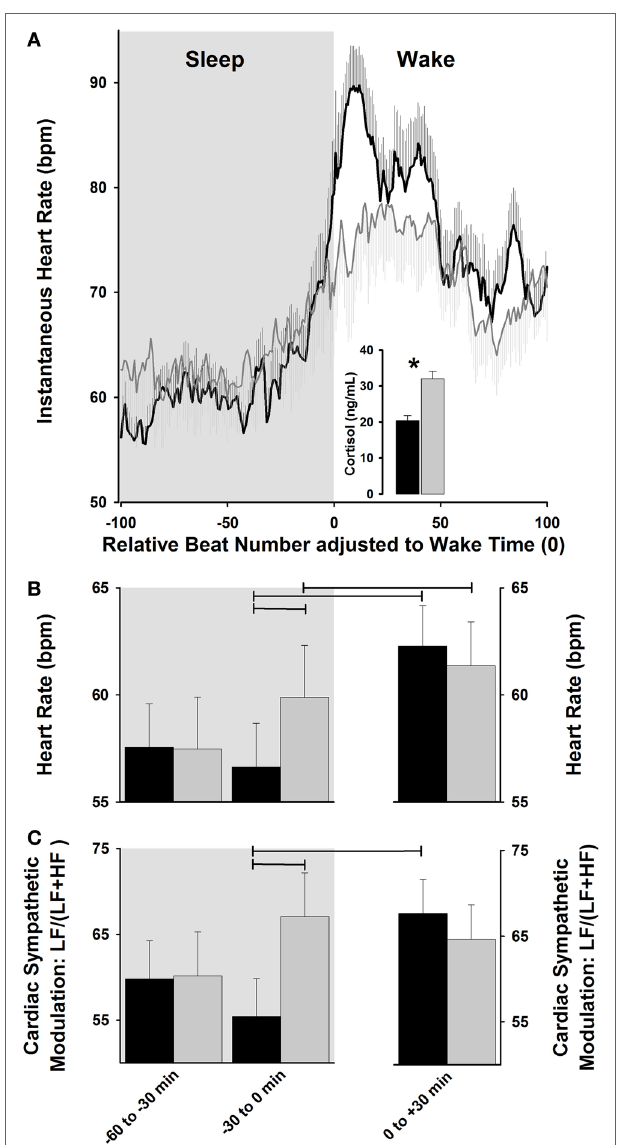
FiGURe 2 | Cardiac modulation during sleep–wake transition. (A) Exposure to dawn stimulating light [dawn simulation light (DSL); gray lines] increases instantaneous heart rate (HR) relative to control dim light (black lines), and is associated with a higher cortisol increase. (B,C) DSL exposure (gray bars) progressively increases HR and relative cardiac sympathetic [LF/(LF + HF) ratio] levels during sleep-to-wakefulness, relative to control dim light (black bars). Horizontal lines: p < 0.05. Reproduced with permission from Viola et al.